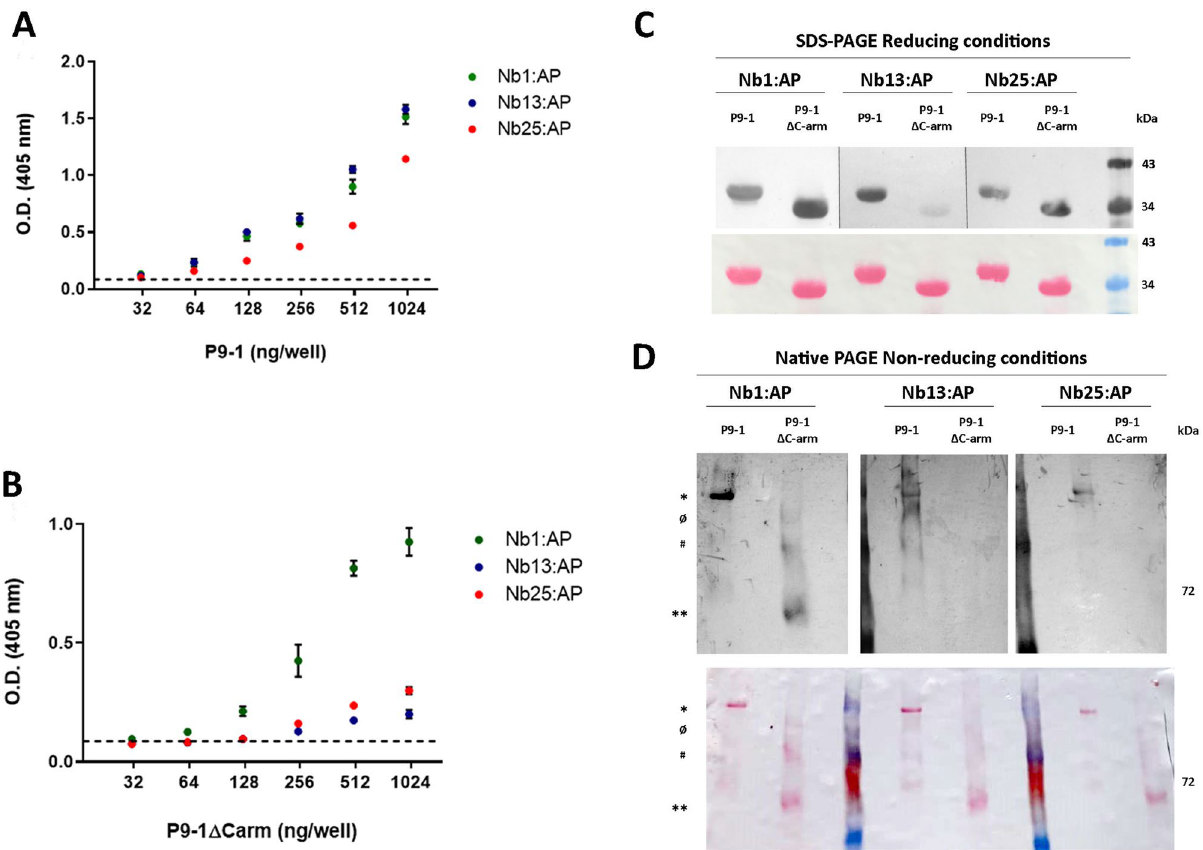
Figure 4. P9-1 and P9-1 ΔC-arm detection by western blot and direct ELISA with Nb:AP fusions. For direct ELISAs, plates were coated with either twofold dilutions of P9-1 ( A ) or P9-1 ∆C-arm ( B ) from 1000 to 31.25 ng/ well and Nb:AP fusions were added in 1.25 ng/µl to determine their specificity towards wild type P9-1 and P9-1 ∆C-arm. Values are means ± SD (n = 3, experimental triplicates). Dashed lines indicate assay cut-off (mean of blanks plus 3*SD of blanks). ( C ) 10 µg of purified P9-1 and P9-1 ΔC-arm were subjected to SDS-PAGE. In reducing conditions, both proteins migrate as monomers. ( D ) 5 µg of purified P9-1 and P9-1 ΔC-arm were subjected to a native-PAGE. In these non-reducing conditions, P9-1 (indicated with *) migrates as a homomultimer, while multimerization of P9-1 ΔC-arm (**) is affected. The presence of P9-1 ΔC-arm aggregates can be detected as faint bands of higher molecular weights (ø and #). In ( C ) and ( D ), detection was performed with the different Nbs fused to alkaline phosphatase (AP) and by adding NBT/BCIP. Total protein load and transfer is revealed by Ponceau S staining below each western blot. In both cases, PageRuler™ prestained ladder was employed as protein molecular marker. However, since it is a size standard for SDS-PAGE, only the red standard protein of 72 kDa could be identified in the native-PAGE, serving only as an approximate reference in the latter case. Blots from ( C ) and ( D ) were cropped and grouped to simplify the Figure